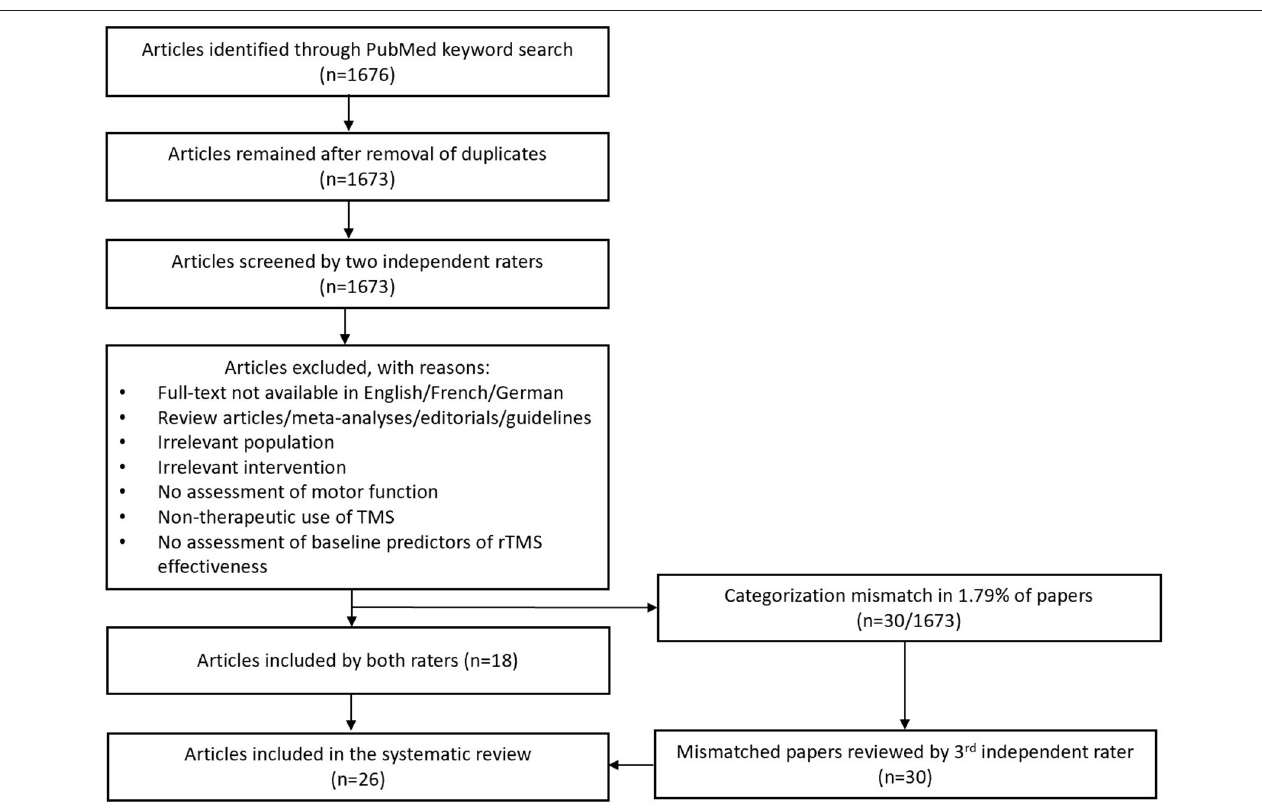
FIGURE 2 | Study selection procedure. rTMS, repetitive transcranial magnetic